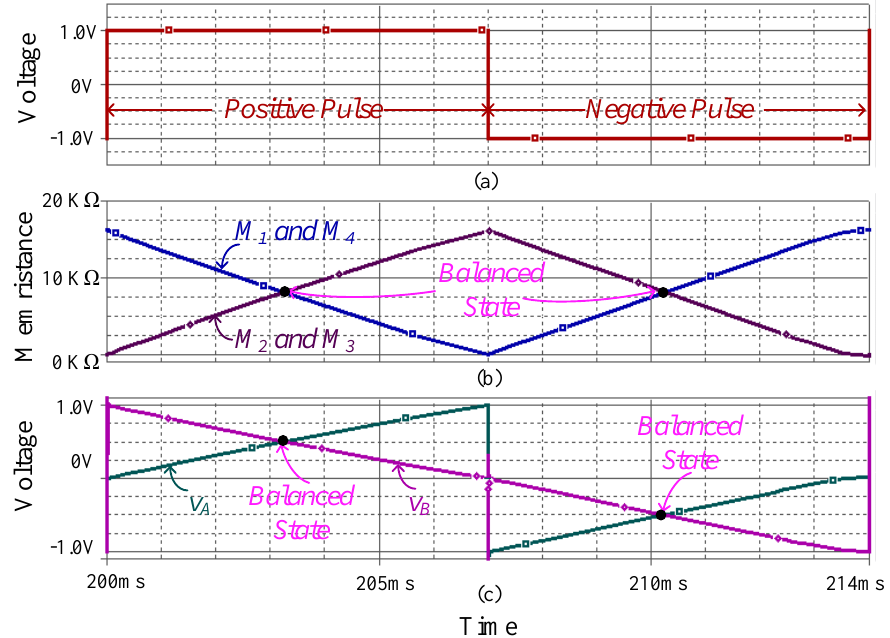
, v ) when positive and negative pulses A B and v A B